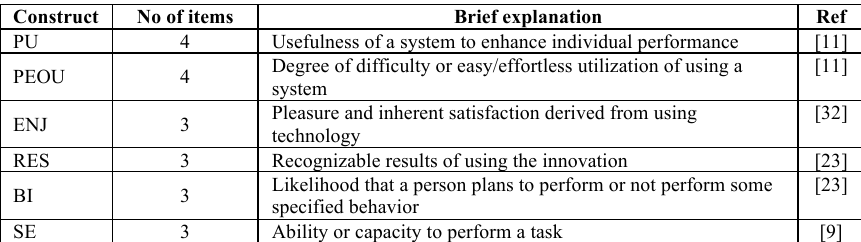
Table 1. A summary of model